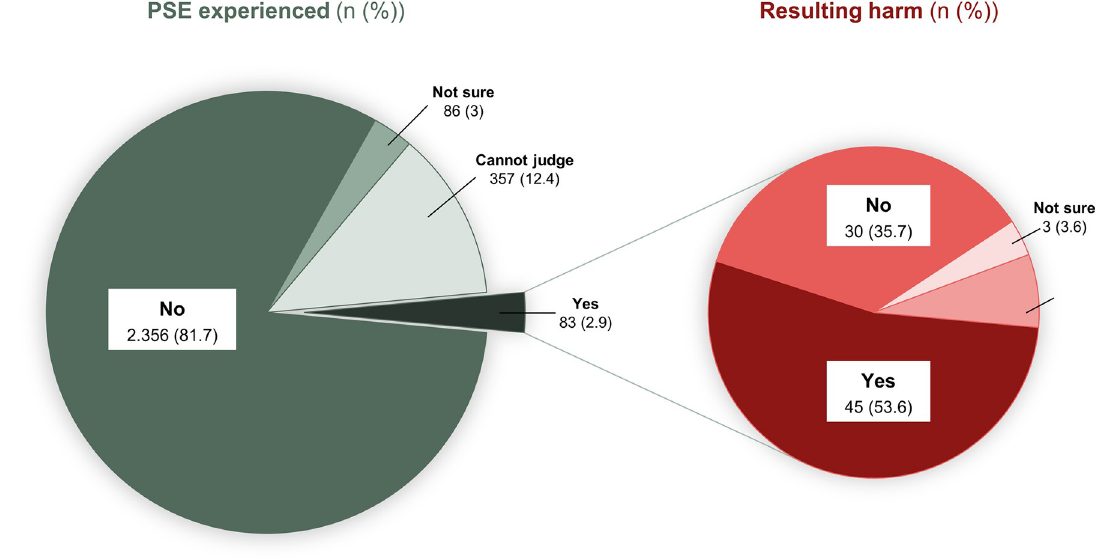
Fig 2. Experience of PSE and resulting